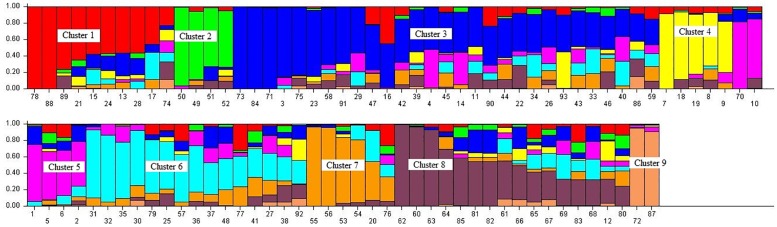
Population structure based on 93 genotypes and 16,383 DArTseq markers.Each colored segment per genotype estimates the membership fraction to each of the 9 populations. See Table 1 for codes of genotypes.